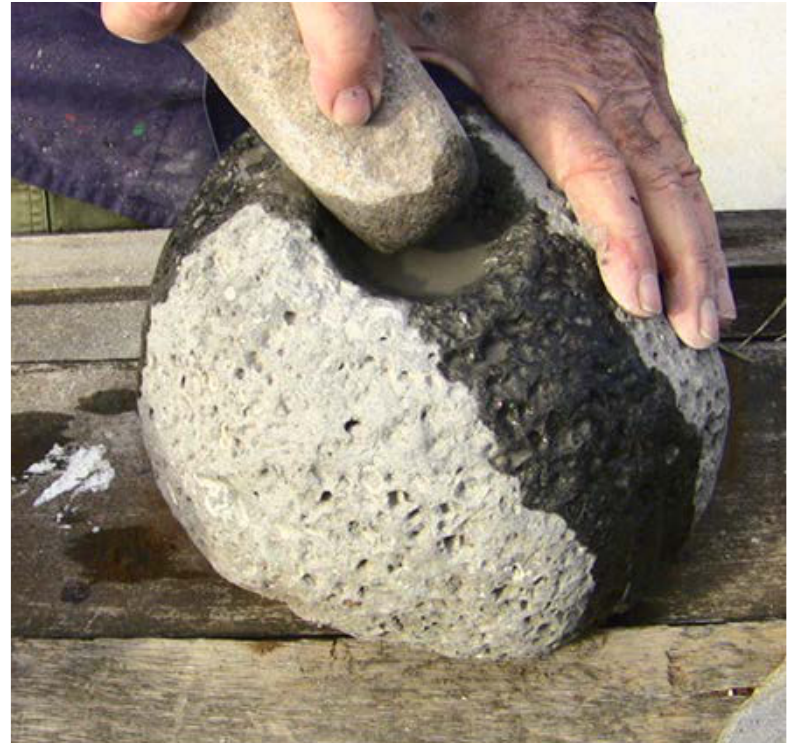
Figure 5. One side of the cavity is being polished by using the tool on its side, mixing water and basalt powder.